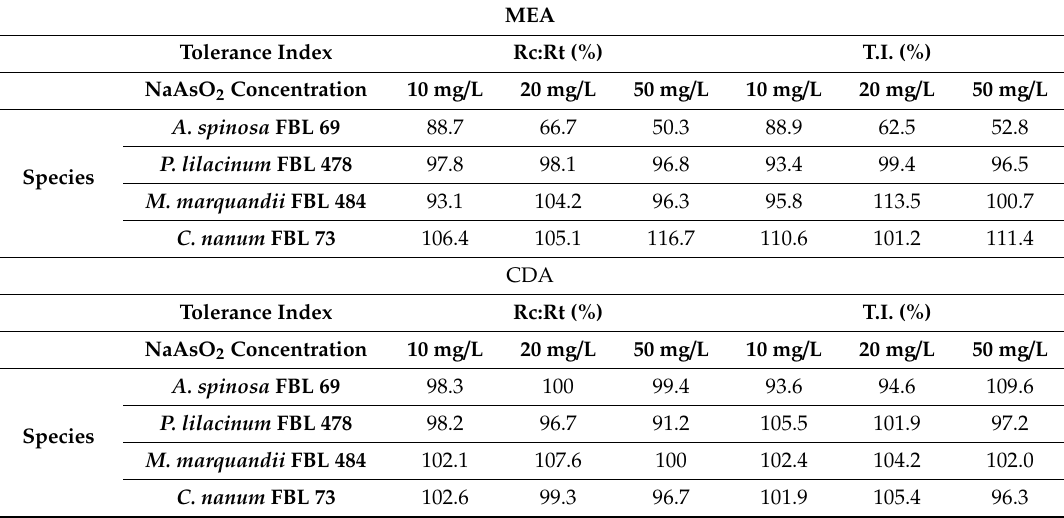
Table 3. Tolerance indexes of the tested species exposed to arsenic (Rt:Rc and T.I.) on Malt Extract Agar (MEA) and Czapeck Dox Agar (CDA) a